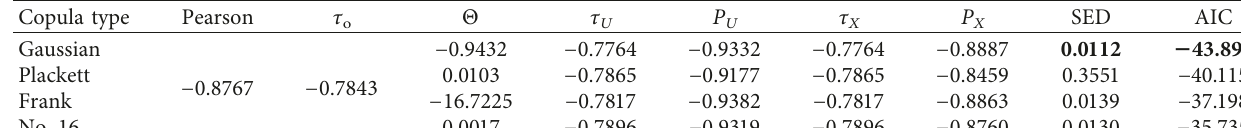
Table 6: Related parameters of copulas for c and φ .